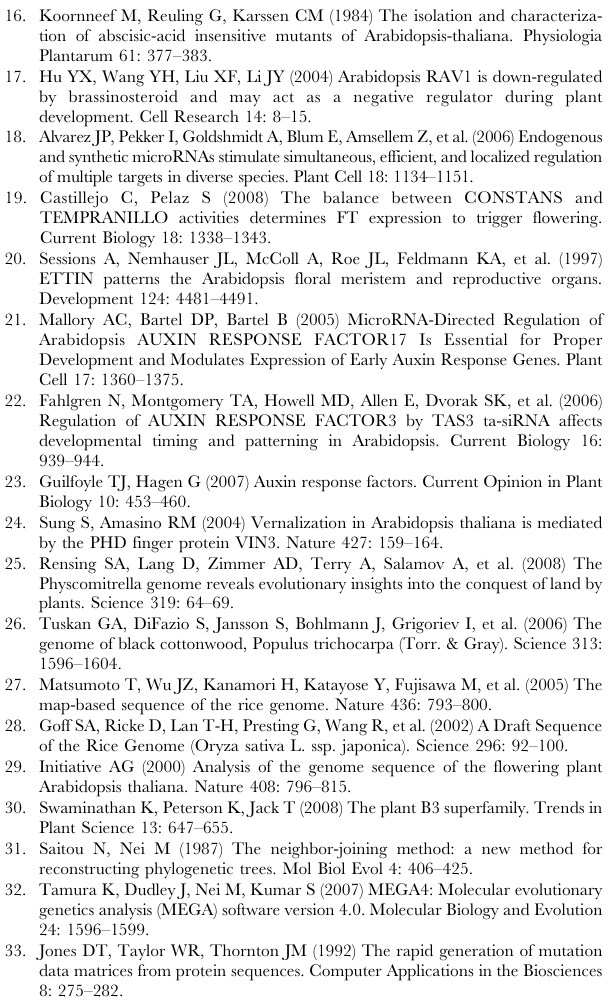
Table S6 List of detected age estimation in B3 proteins. dS, YA and MYA means synonimous distance, years and million years ago. Table S7 In silico Expression analysis of B3 genes. Gene ID and additional information about the A. thaliana B3 genes used in this study. The source for all sequences and mean-value expression was the TAIR data bank and AtGenExpress [74],